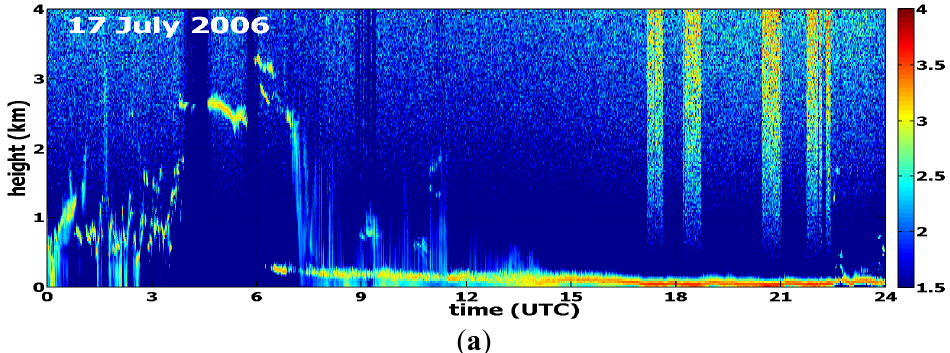
Figure 3. Two-dimensional images of Vaisala Ceilometer (VCEIL) normalized backscatter for 17 July 2006 ( a ), 25 June 2008 ( b ), and 26 June 2008 ( c ), corresponding to the days shown in Figure 2. Note that a single cloud layer with long duration is located near the surface (below 0.5 km) at local noon on all three days. Increasing color wavelength (blue to yellow to red) represents increasing backscatter. Color scale defines amplitude (log of